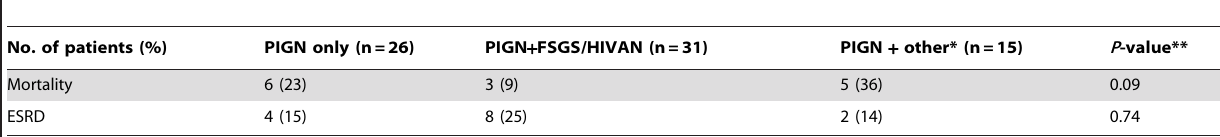
Table 4. Estimated rates of mortality and ESRD 12 months following kidney biopsy, according to pathologic findings.